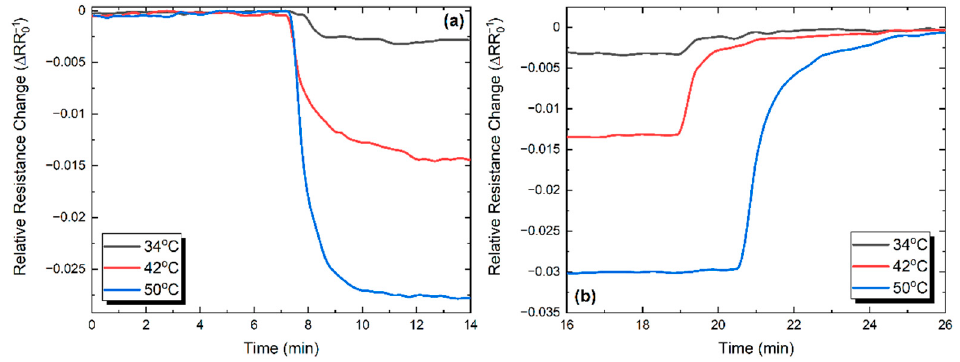
Figure 13. Normalized response ( a ) and recovery ( b ) behavior for three thermal pulses for the graphene sample.